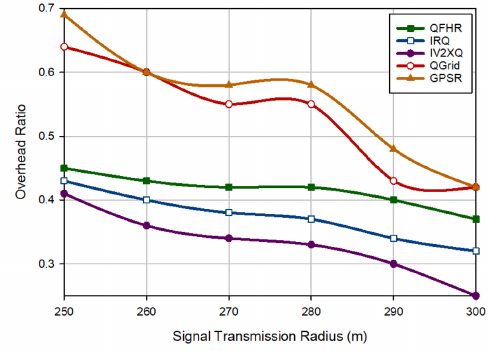
Figure 17. Routing overhead in different approaches based on